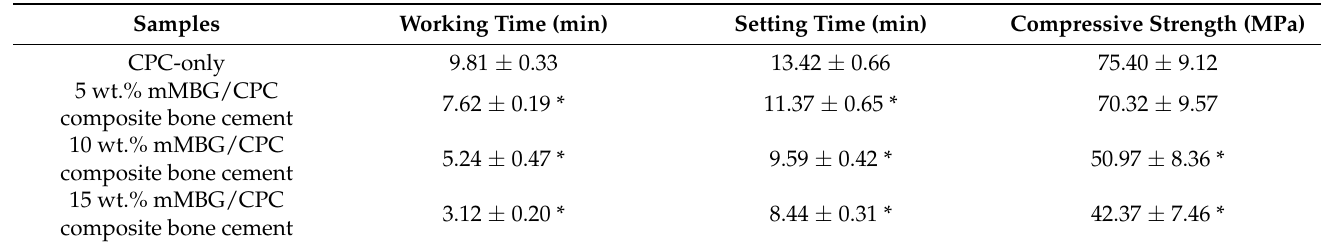
Table 1. Measured working and setting times, and compressive strength of CPC composite bone cements with different mMBG ratios. ( n = 10).